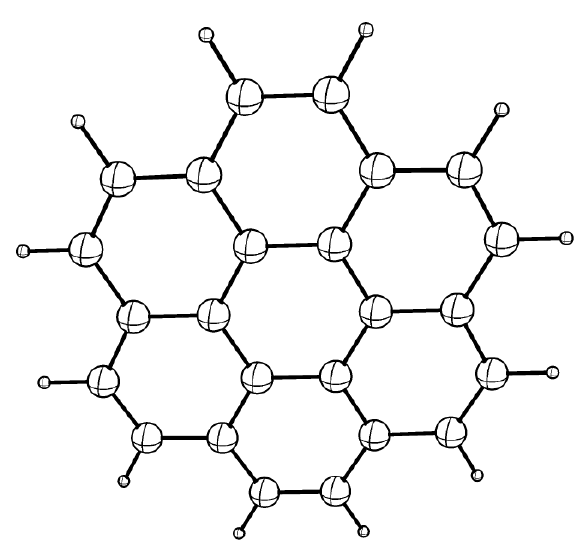
Fig. 1. The model of graphene